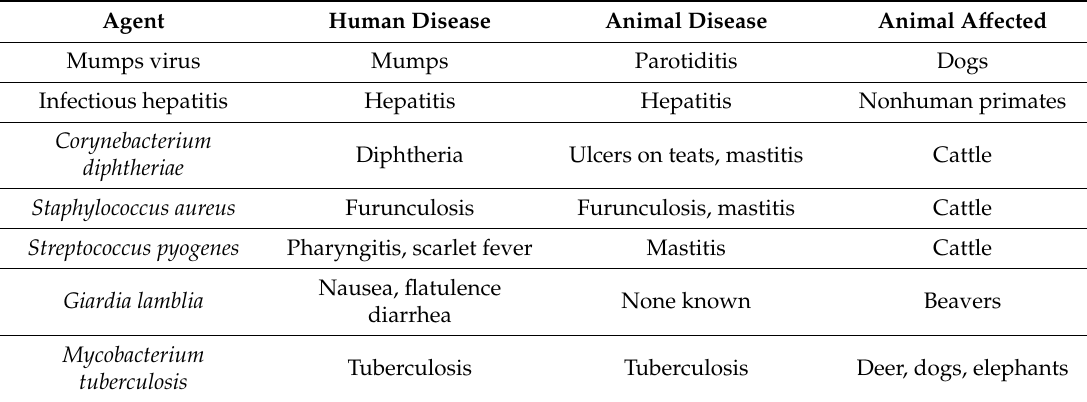
Table 2. Examples of reverse zoonoses (retrieved from